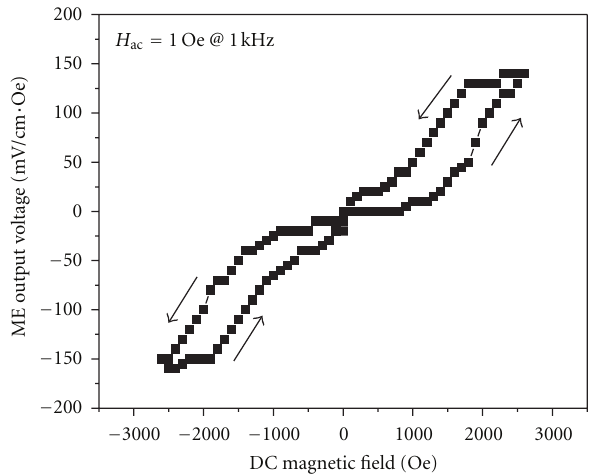
Figure 7: ME coe ffi cient of 3-2 nanocomposite ME thick films by AD as a function of magnetic DC bias. The maximum ME coe ffi cient was measured to be 150 mV/cmOe. This magnitude is about 3 times higher than the previously reported nanocomposite films by other thin film processes,